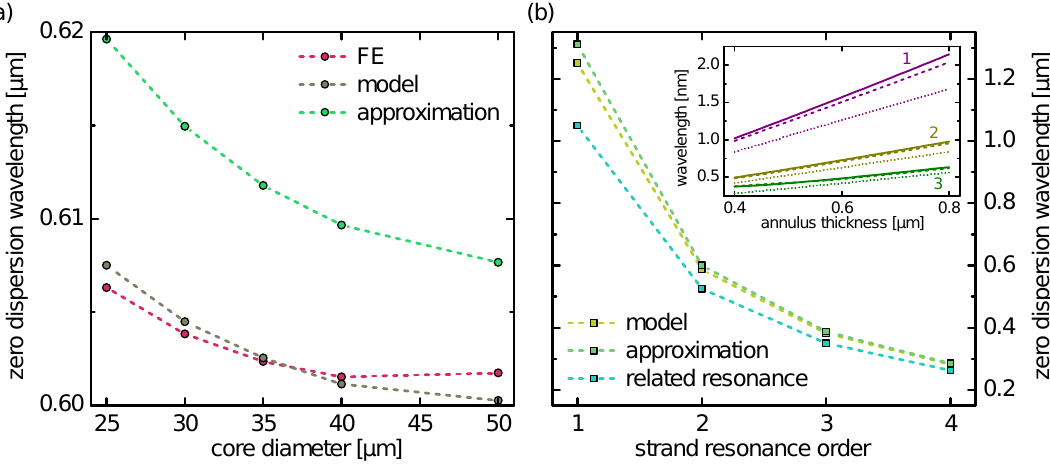
Figure 5. ( a ) dependence of the zero-dispersion wavelength on central core diameter ( w = 0.5 µ m). The three curves show the evolutions from the numerical FEM calculations (red) for n = 6 and d = 20 µ m, the TTF model (Equation (6), gray) and the expression that approximate the ZDW (Equation (12), green); ( b ) ZDW vs. annulus resonance order (yellow: TTF model; green: approximate expression (Equation (12))). The cyan symbols show the related annulus resonance (according to Equation (13)). The connecting lines are only guides to the eye. The inset shows the dependence of the ZDW in case the ring thickness is changed (2 R = 50 µ m) for the three lowest resonance orders (solid lines: analytic equation (Equation (6); dashed lines: model (Equation (12)); dotted lines: corresponding resonance (Equation (13)). The colors refer to the different resonance orders (indicated by the respective numbers). Both plots assume argon and silica as gas and glass, respectively, and do not include the core diameter correction factor (i.e., f =